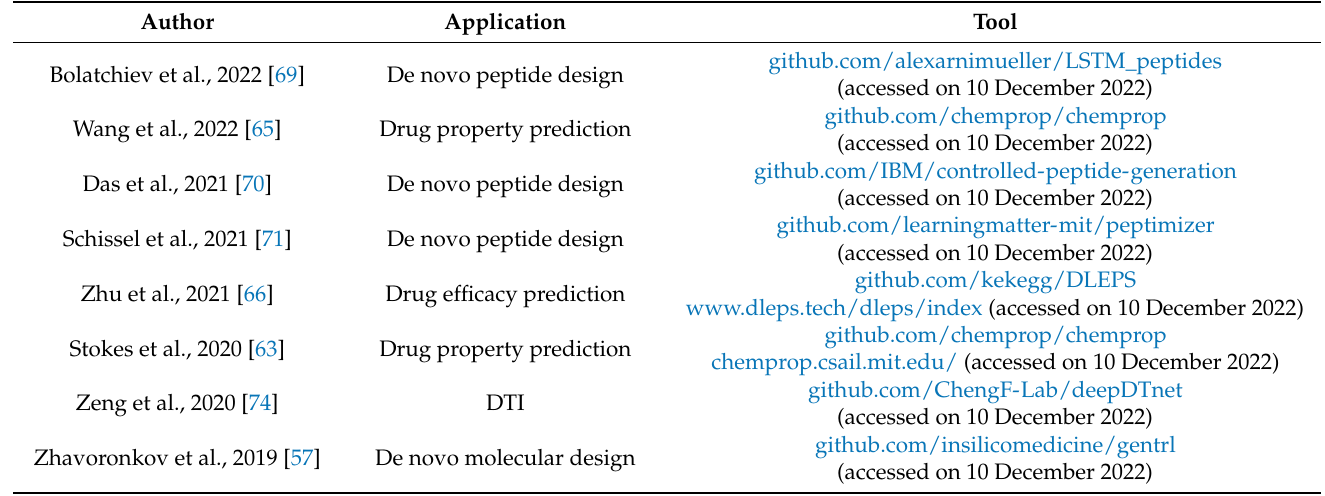
Table 3. Open-source codes and web applications for different tasks of computational drug discovery presented in this systematic